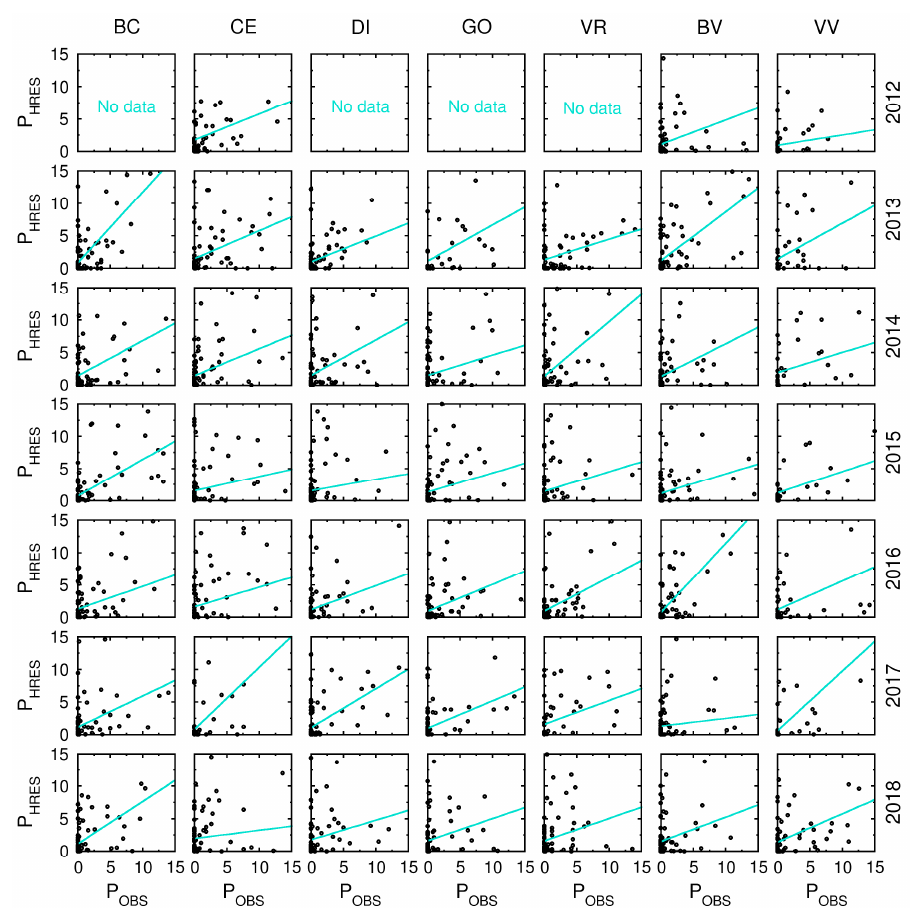
Figure 4. Comparison between observed (P OBS ) daily precipitation and that forecasted by the HRES model (P HRES ) in mm at selected locations during MAM 2012–2018.